Question: According to the figure, is the described quantity increasing or decreasing?
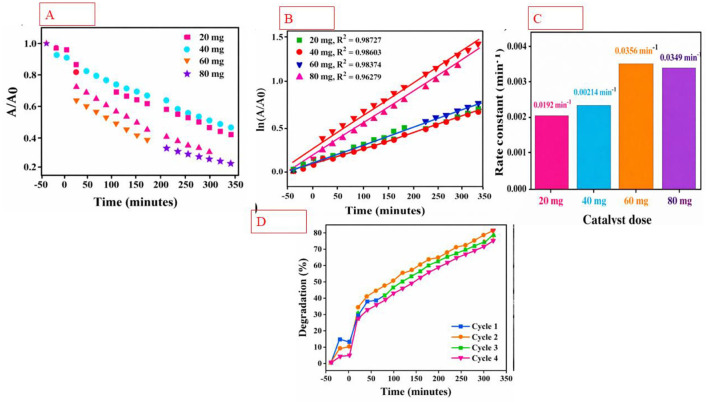
Answer: increasing